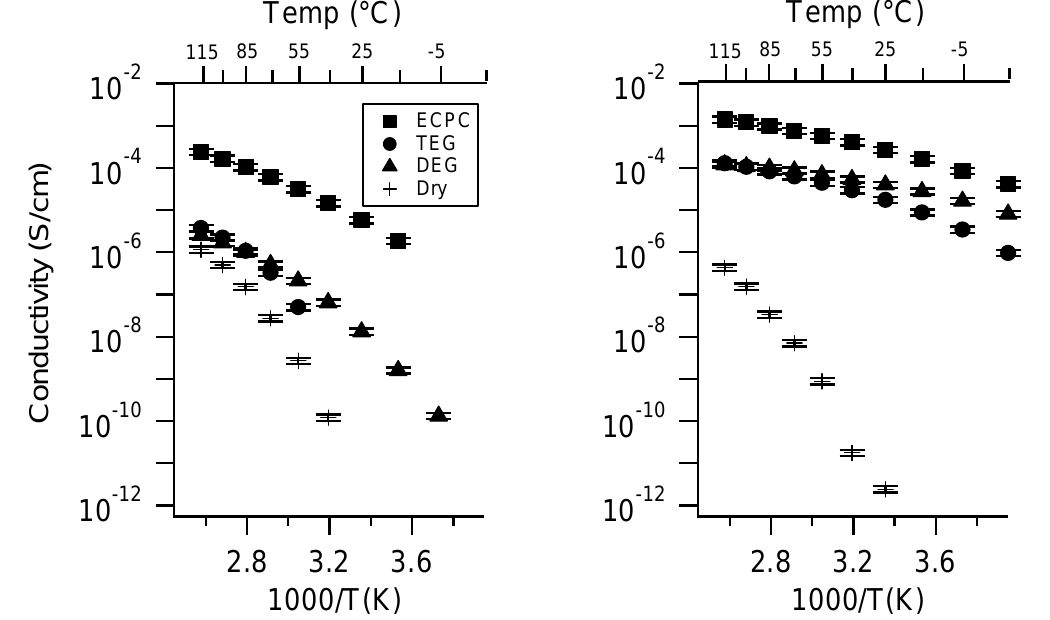
Figure A29 . Conductivity as a function of solvent for PEGDMA1000_high_SSK (left) and PTHFDA1000_high_STFSIK (right) SIPEs. Temperatures ranged from − 20 °C to 115 °C. Note that there may be a non ‐ negligible fraction of electronic conductivity in conditions where conductivity of less than 10 − 9 S/cm is reported.